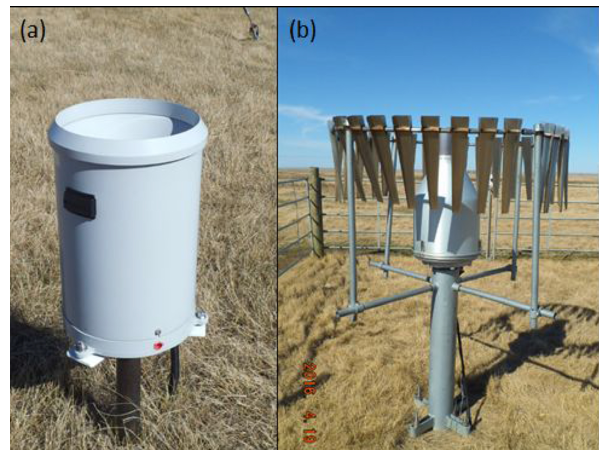
Figure 2. Two types of precipitation gauge used in this study: (a) tipping bucket rain gauge; (b) the single Alter-shielded Geonor T200-B precipitation